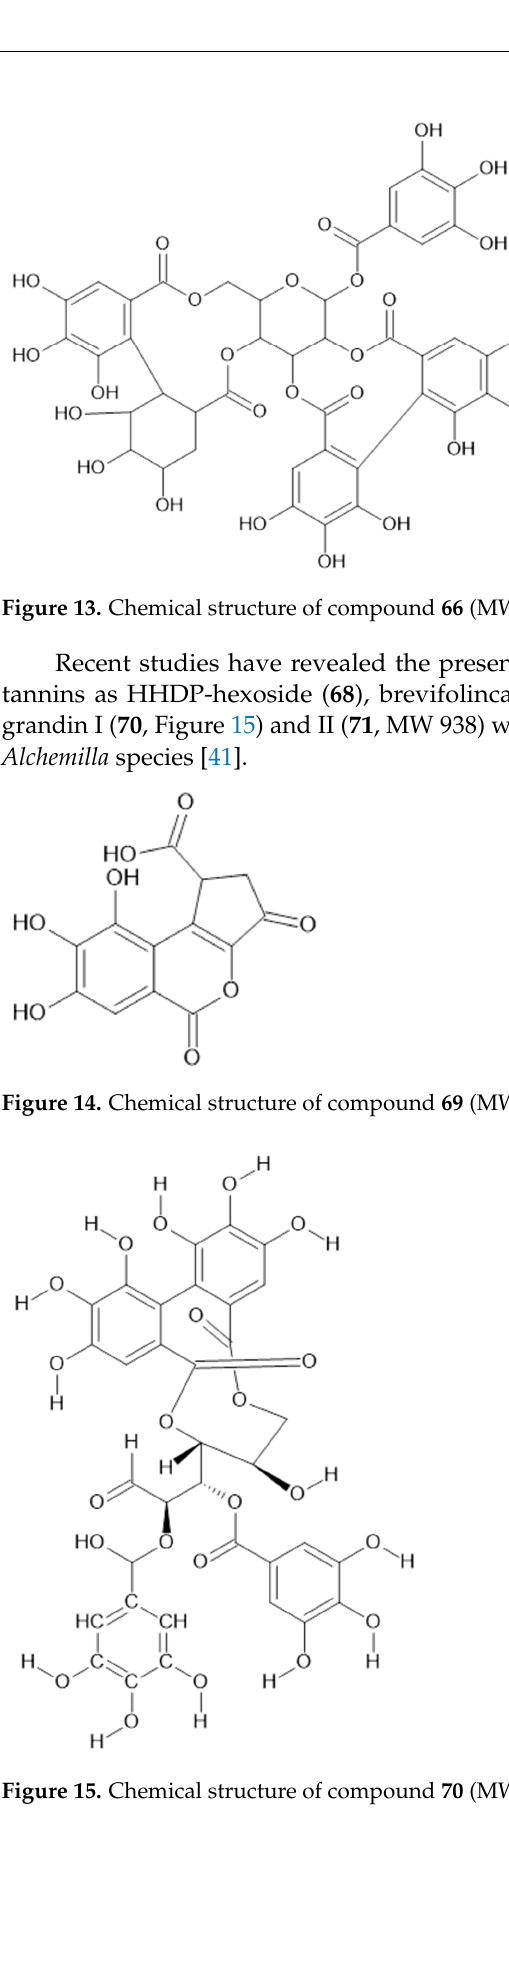
Figure 16. Hydroxycinnamic acid derivatives. Table 8 . Hydroxycinnamic acid derivatives. Compound